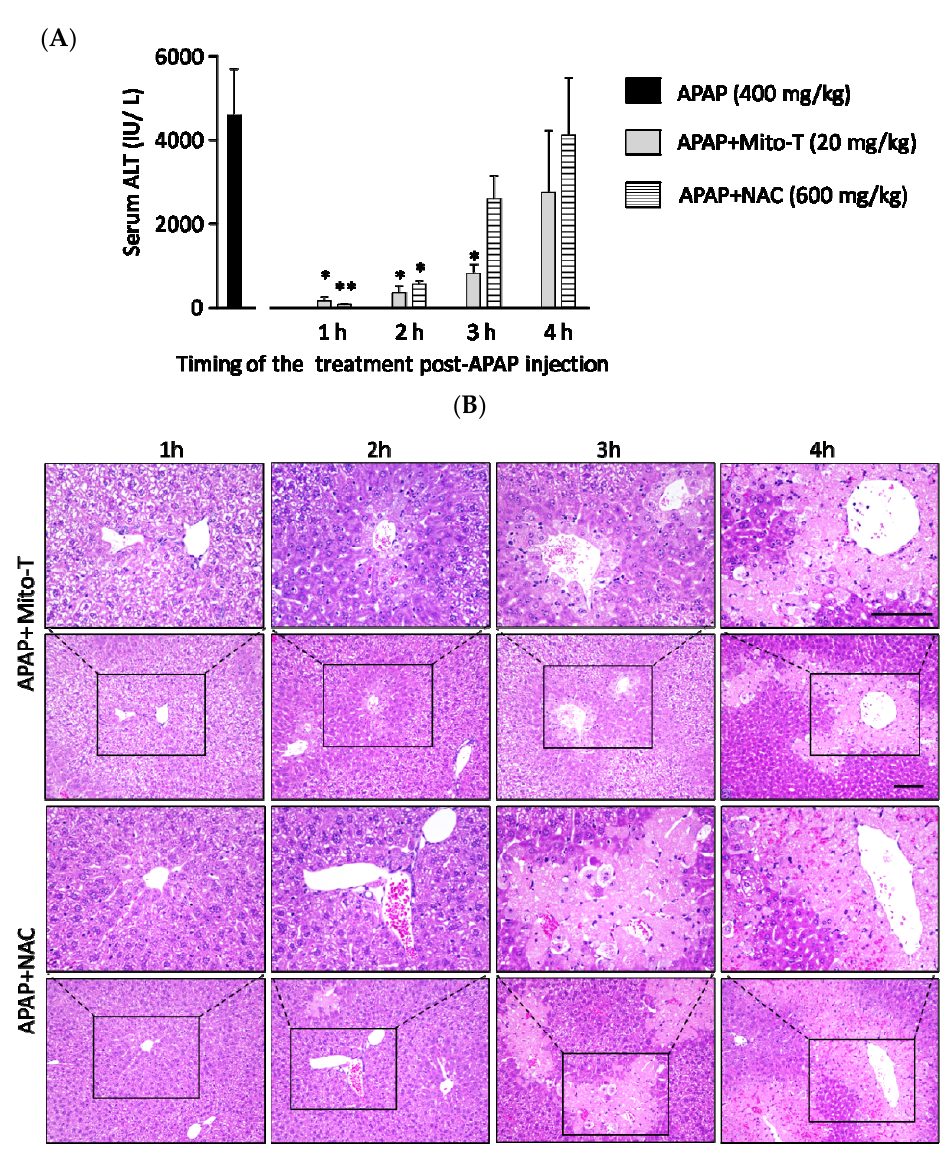
Figure 4. Therapeutic time window of Mito-T and NAC. Mito-T (20 mg/kg, i.p.) or NAC (600